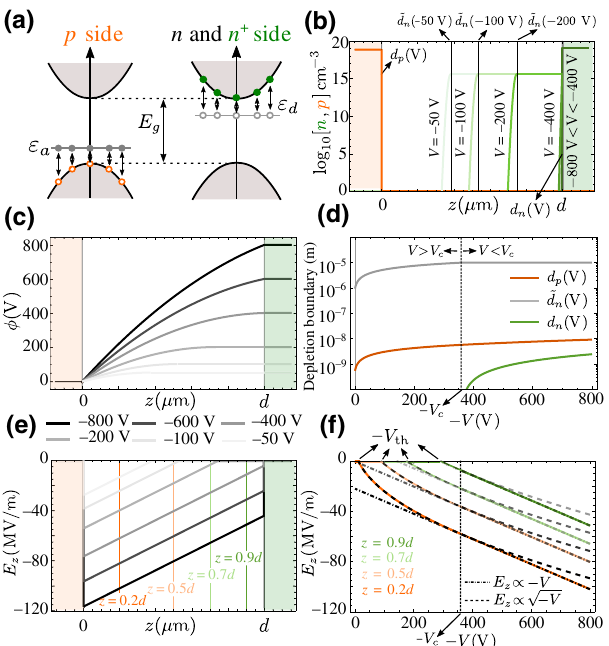
FIG. 2. (b) Electron ( n ) and hole ( p ) density carriers in the z direction for different applied reverse voltages V . (c) Electrostatic potential φ( z ) along the diode for voltages V ranging from − 12 to − 400 V. (d) Depletion region boundary positions as a function of V . (e) Electric field profile in the z direction for voltages V ranging from − 12 to − 400 V. (f) Electric field as a function of V at four different positions: z = 0.2 d , z = 0.5 d , z = 0.7 d , and z = 0.9 d .